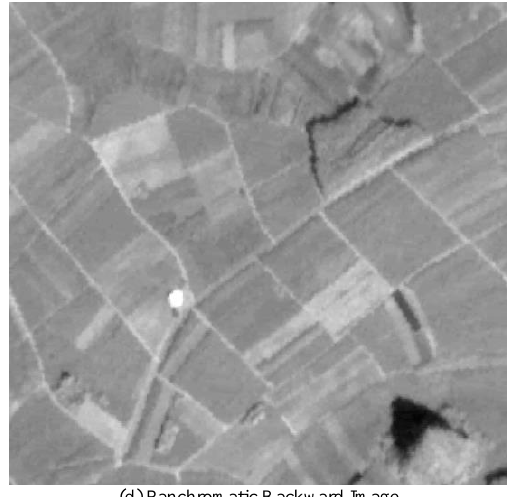
Figure 3. Comparisons of sugarcane crop in ZY-3 TLC images